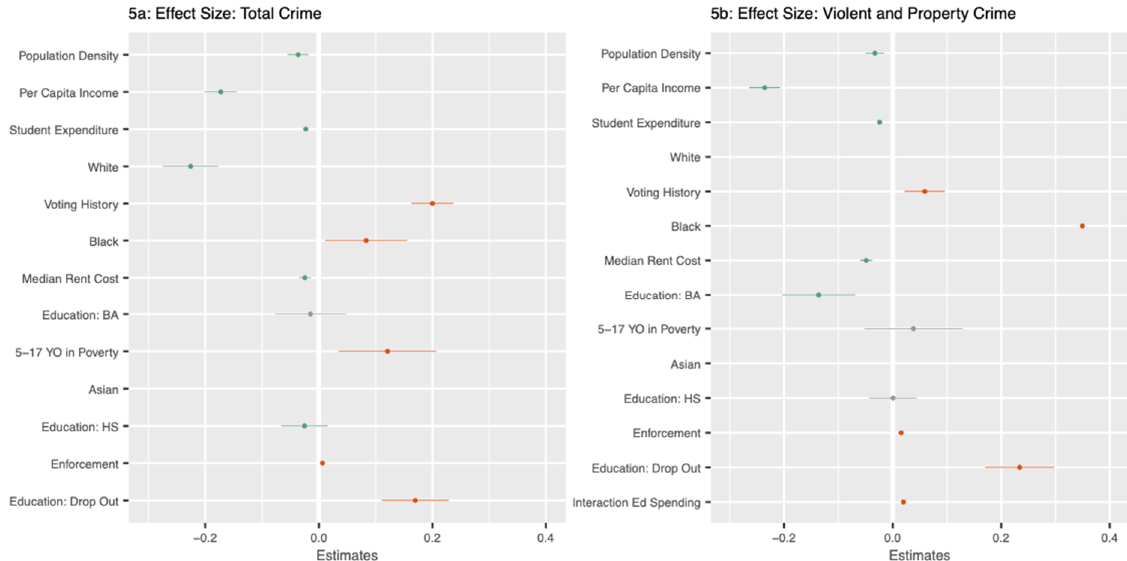
Figure 5. Standardized coefficient values controlling for all predictors. First, we plot the effect sizes of coefficients on all crime; then we separate crime between property and violent also including an interaction. Education spending has a small but meaningful influence on crime. The graph of total crime and those of property and violent, reveal the meaningful nuances among effects: on average, increases in student expenditure, per capita income, and unemployment yield decreases in property crime. The Interaction “Ed Spending” is the additional effect of ed spending on violent crime. We removed both population and Asian variables to make other values more visible: their respective values are 1.21 and − 0.75 for Figure 7a and 1.12 and − 0.77 for Figure 7b.